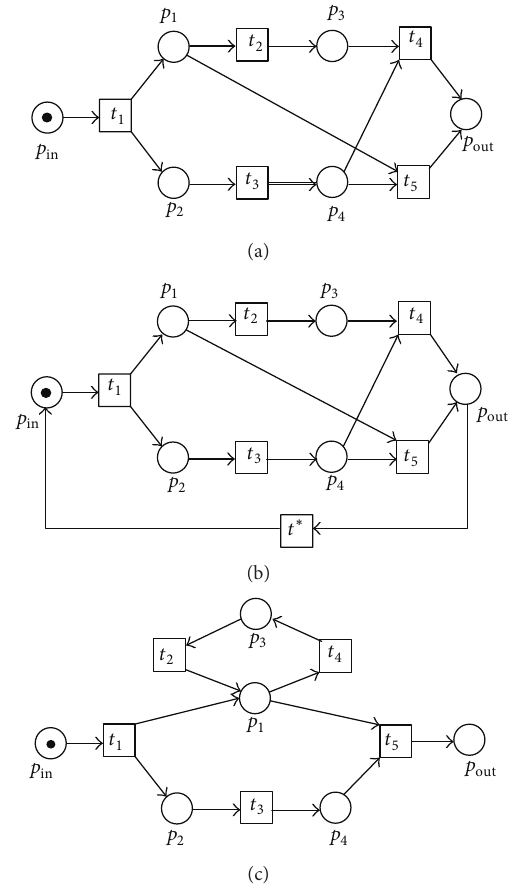
) , (b) the extended WF- in